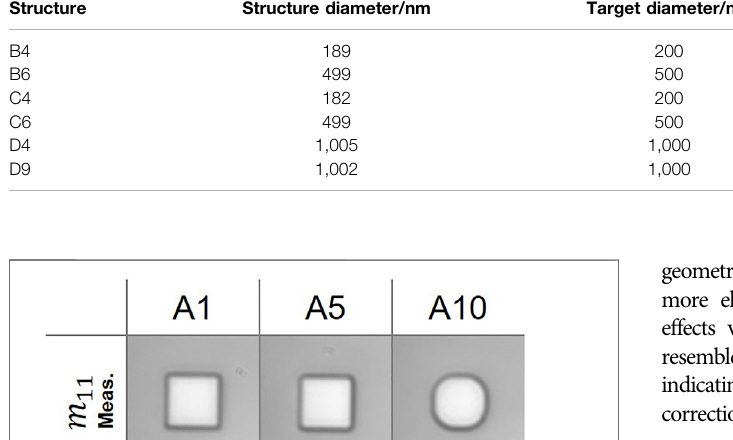
TABLE 3 | Feature sizes of structures in row B, C, and D, measured by AFM.